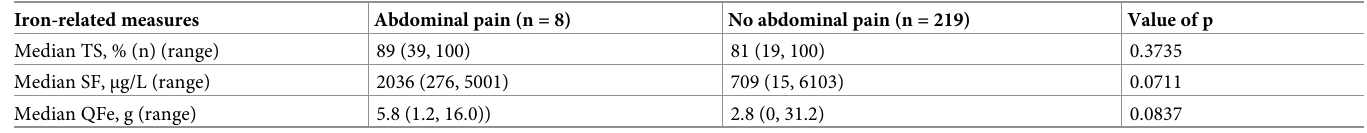
Table 3. Abdominal pain in hemochromatosis probands with HFE p.C282Y homozygosity. Iron-related